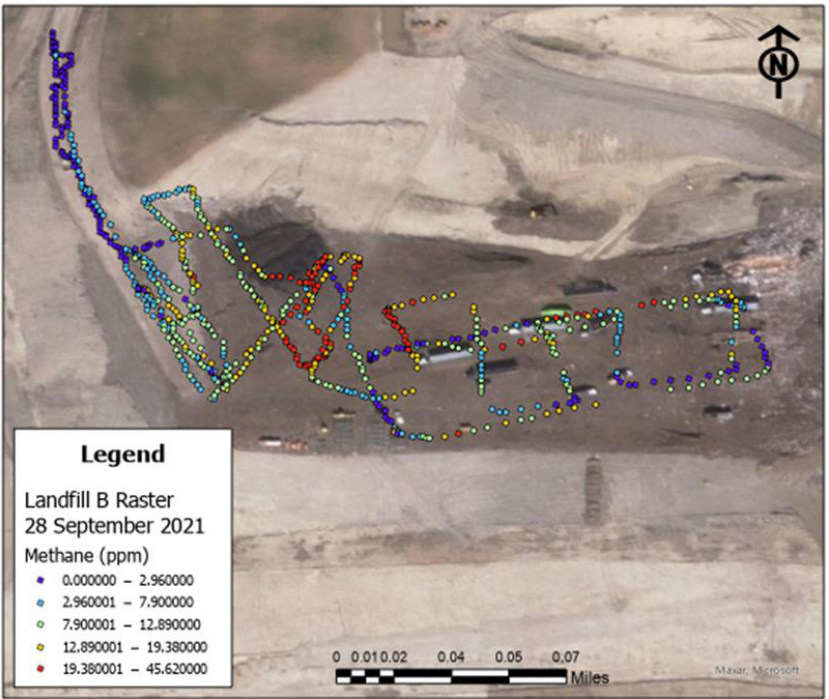
Figure 16. DR1000 raster measurements of methane at Facility B on 28 September 2021. The maximum altitude of the measurements was roughly 28 m above the set point.